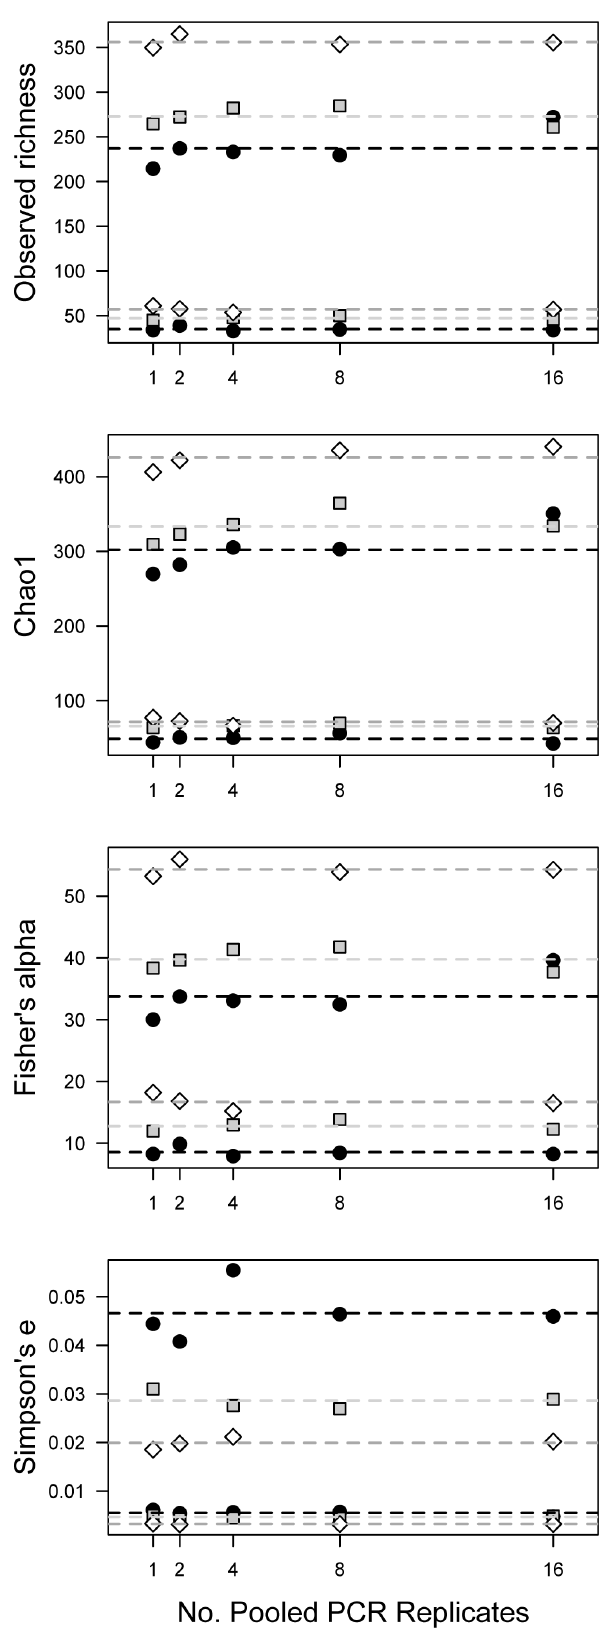
Figure 1. Estimated species richness does not depend on the number of PCR reactions pooled prior to sequencing. Plots of independent replicates representing different levels of PCR pooling for samples CT2, OR1, and OR4 against four different diversity indicators. Points are colored by sample ID. Dotted lines represent the average between different replicates of the same sample. The top three lines represent samples sequenced with Illumina MiSeq and the bottoms three lines represent the same samples sequenced with